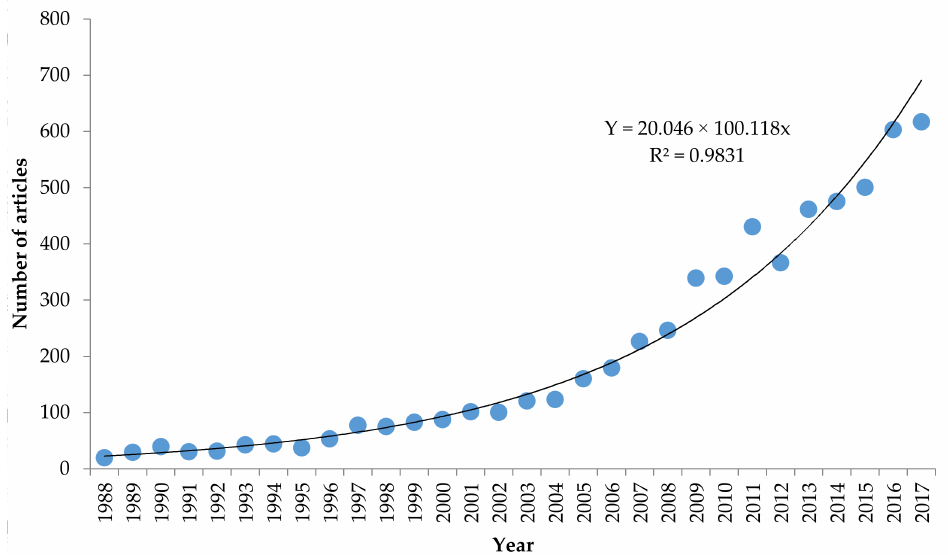
Figure 1. Annual number of articles on WUEA research from 1988 to